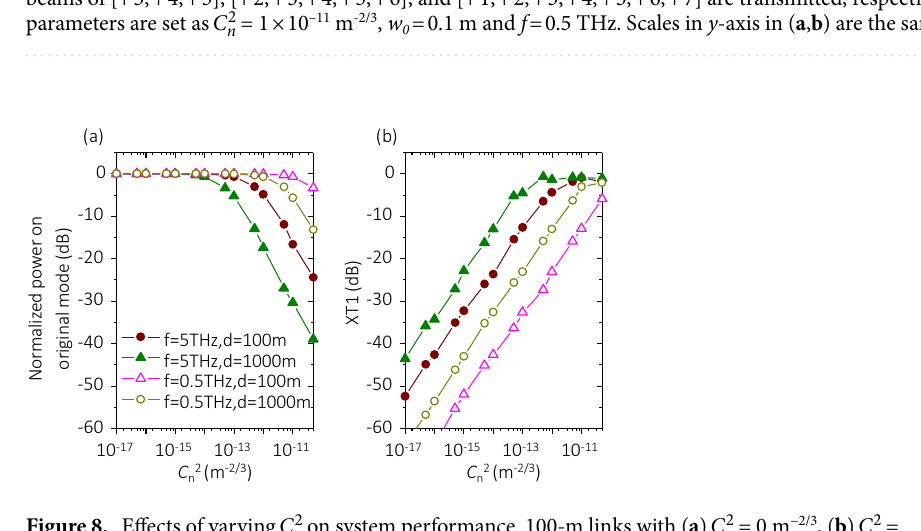
C 2 C 2 n = 0 m −2/3 , ( b ) n =